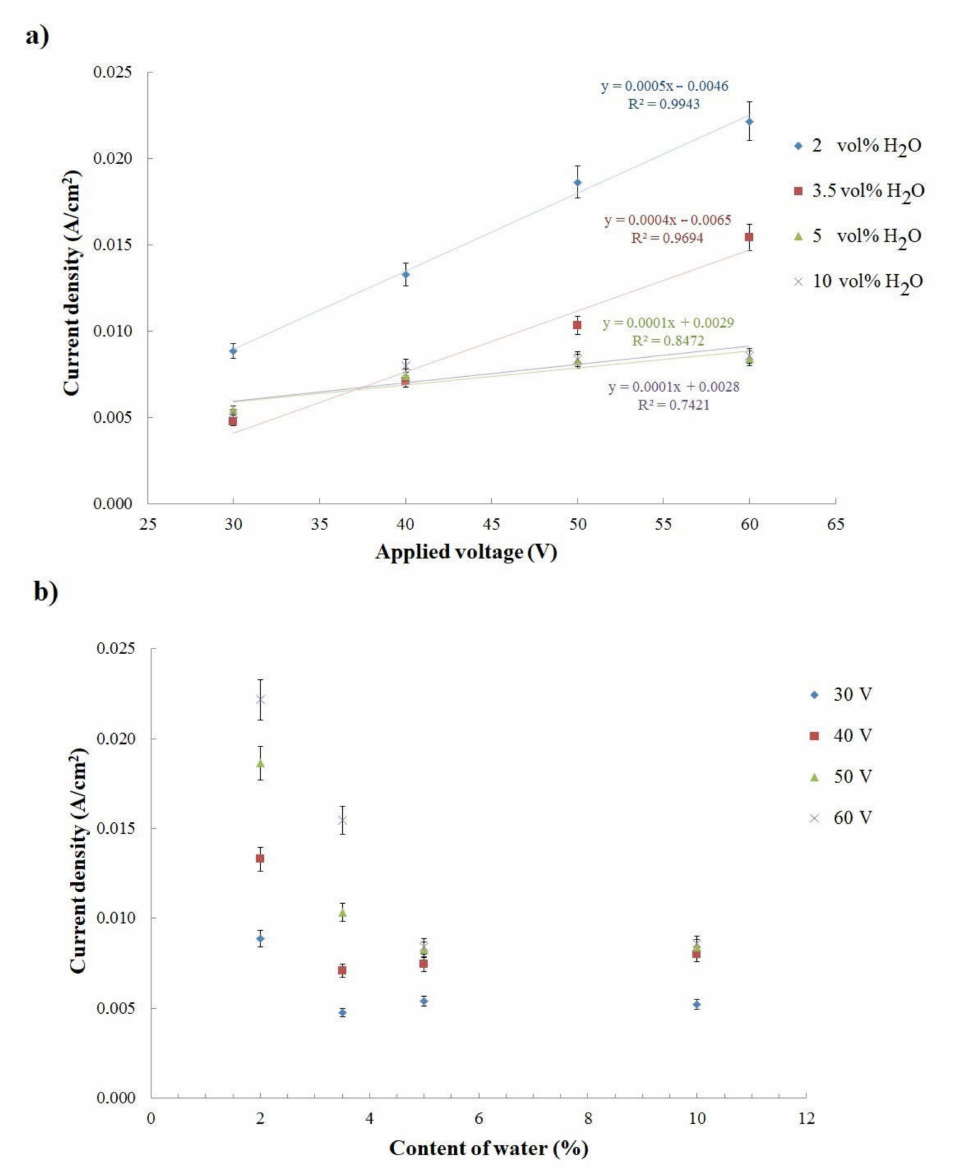
Figure 3. ( a ) Average current density in the function of applied anodizing voltage, and ( b ) water content in the